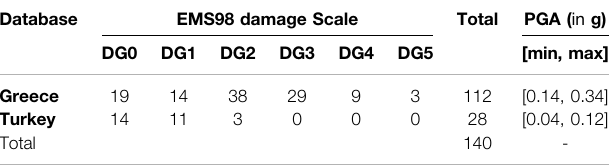
TABLE 1 | Summary of fi eld data for traditional buildings used for the empirical construction of fragility